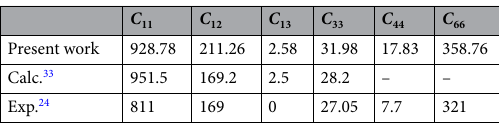
Table 1. Elastic stiffness constants ( C ij ) of h-BN. (in